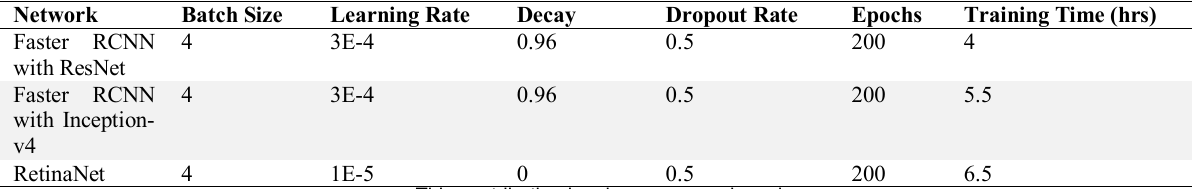
Table 1: Hyper parameters for model training. Dropout rate is a fraction proportion of the feature detectors. Training time is on a single Nvidia 1080Ti